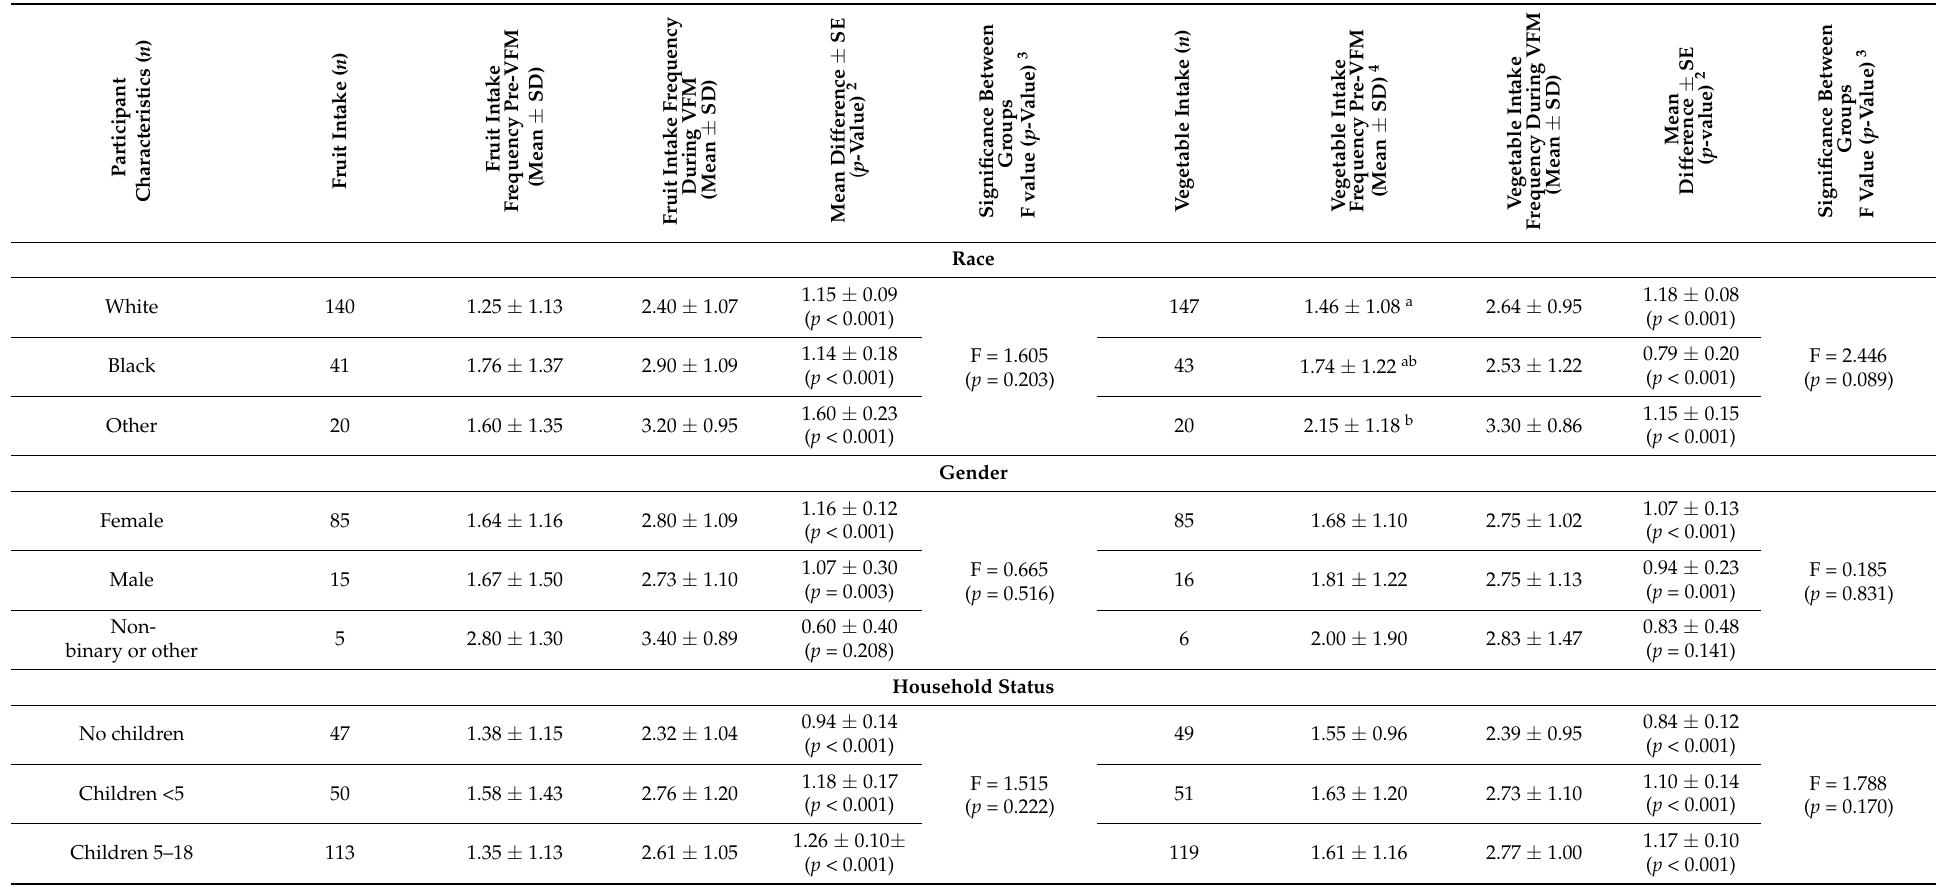
Table 2. Changes in frequency of fruit and vegetable consumption from before to during Virginia Fresh Match incentive use by race, gender, and household status 1